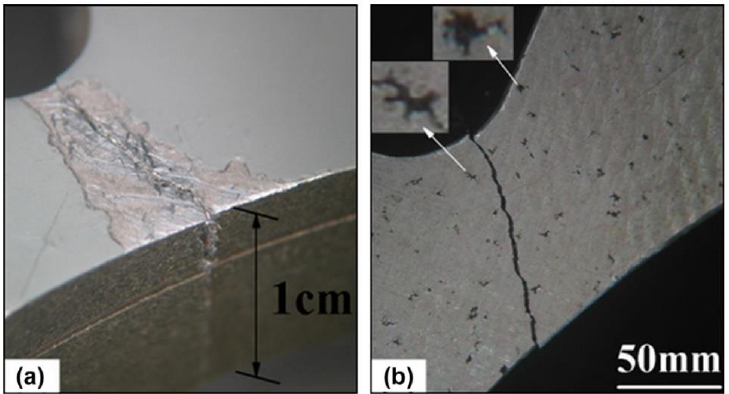
Figure 13. Two failed airplane frame castings ( a , b ) of an Al – Cu – Mn – Ti alloy. Pores are visible in ( b ) Reprinted with permission from ref. [56]. Copyright 2022 Elsevier.